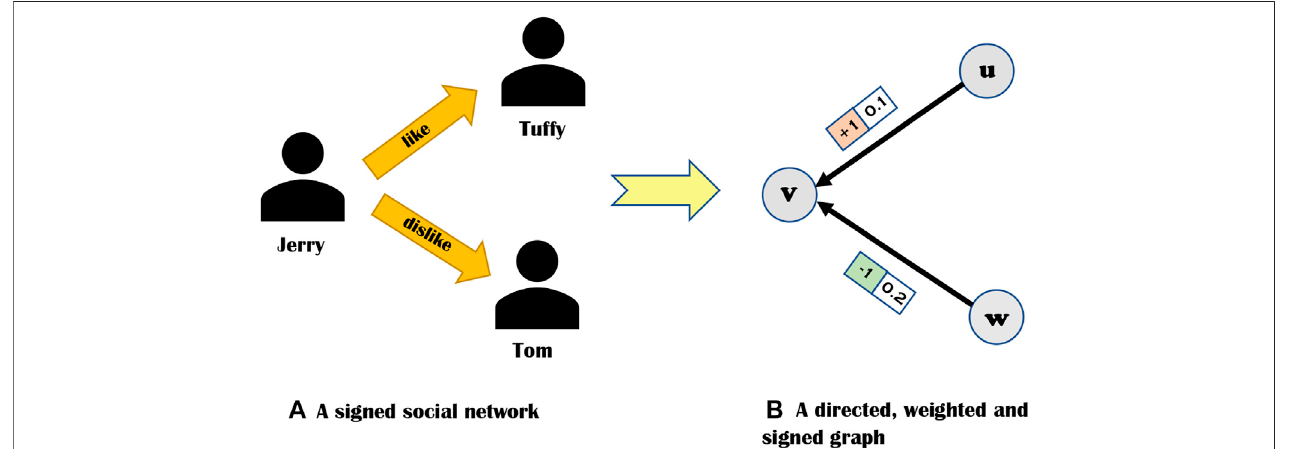
FIGURE 2 | An example of modeling a signed social network. (A) A signed social network (B) A directed, weighted, and signed graph